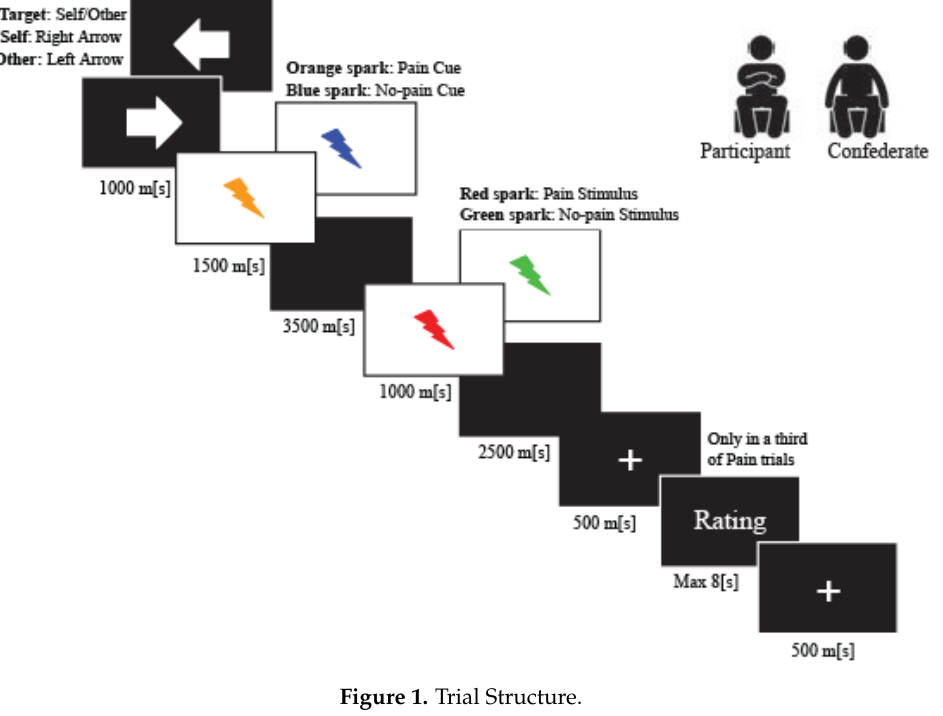
Figure 1. Trial Structure.